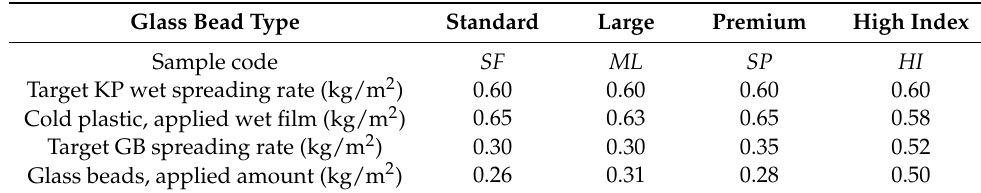
Table 2. Actual spreading rates of KP and GB for abrasive